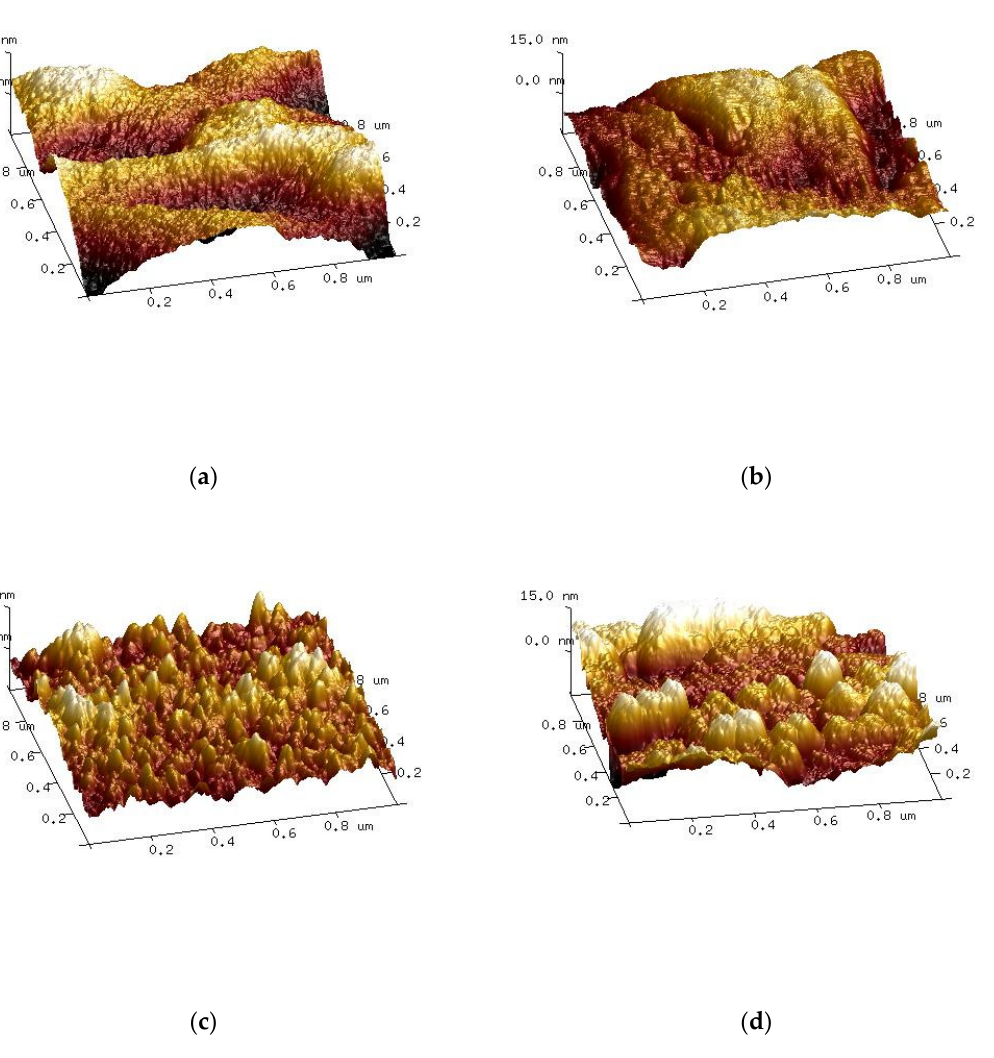
Figure 6. AFM images of the surface of unmodified and samples modified with dialdehyde starch (DAS): ( a ) collagen, ( b ) collagen + DAS, ( c ) chitosan, ( d ) chitosan + DAS. [67], Copyright 2020. Reproduced with permission from Elsevier Ltd. (DAS = dialdehyde starch). Molecules 2020 , 25 , x FOR PEER REVIEW